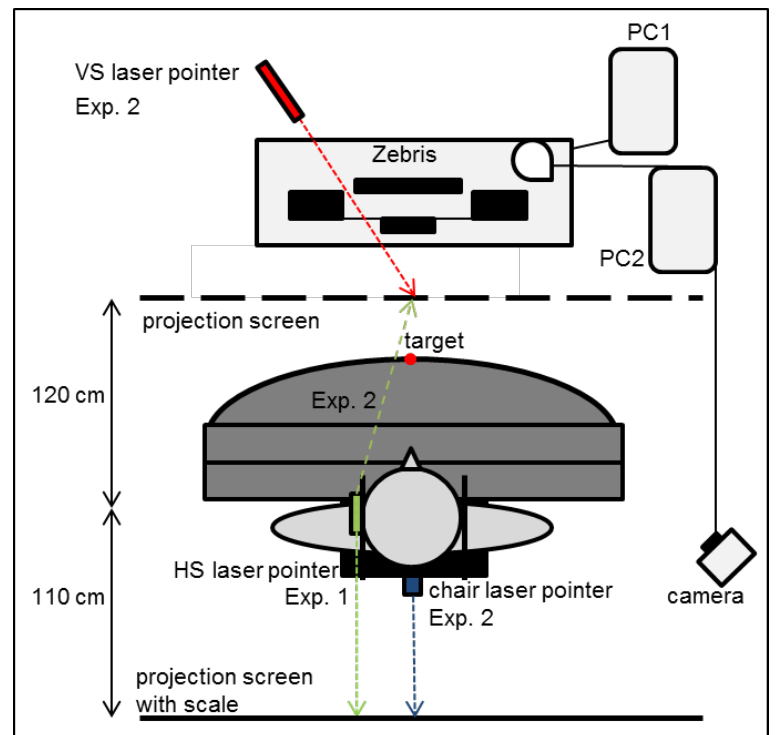
Figure 6. Test set-up from above. A laser pointer (blue; Exp. 2) mounted on the chair projects to a projection screen with measuring scale (black line) behind the participant. White projection screens behind (black line; Exp. 1) and in front of (dashed line; Exp. 2) the participant receive beams of the head laser pointer (green) and of the visual straight ahead movable laser pointer (red; Exp. 2), respectively.